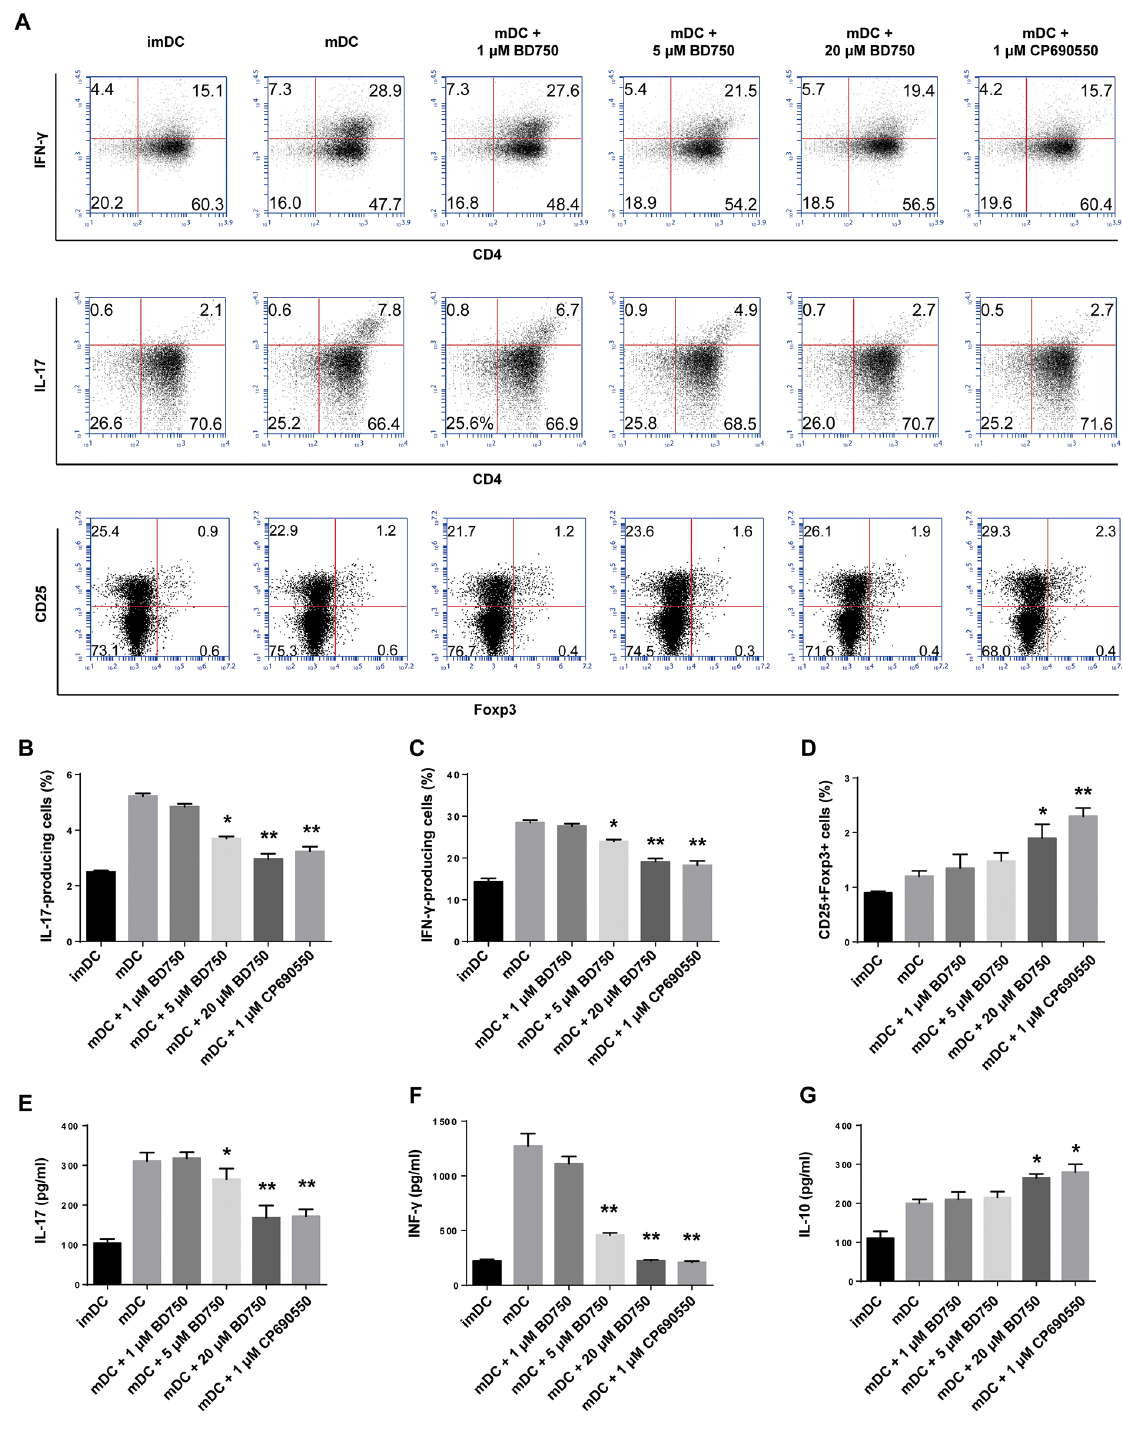
Figure 5. BD750-treated DC impairs allogeneic antigen-stimulated Th1 and Th17 responses in vitro . Following MLR in vitro , the frequency of Th1 and Th17 cells and Tregs was determined by flow cytometry. The levels of IL-17A and IFN- γ in the supernatants of cocultured T and DC cells were determined by ELISA. Data are representative FACS charts or expressed as the mean ± SEM of three independent exper- iments. (A) Flow cytometry analysis of Th1 and Th17 cells and Tregs. (B–D) Quantitative analysis of Th1 and Th17 cells and Tregs. (E–G) ELISA analysis of the levels of IL-17A, IFN- γ and IL-10. * P < 0.05, ** P < 0.01 versus the mDC